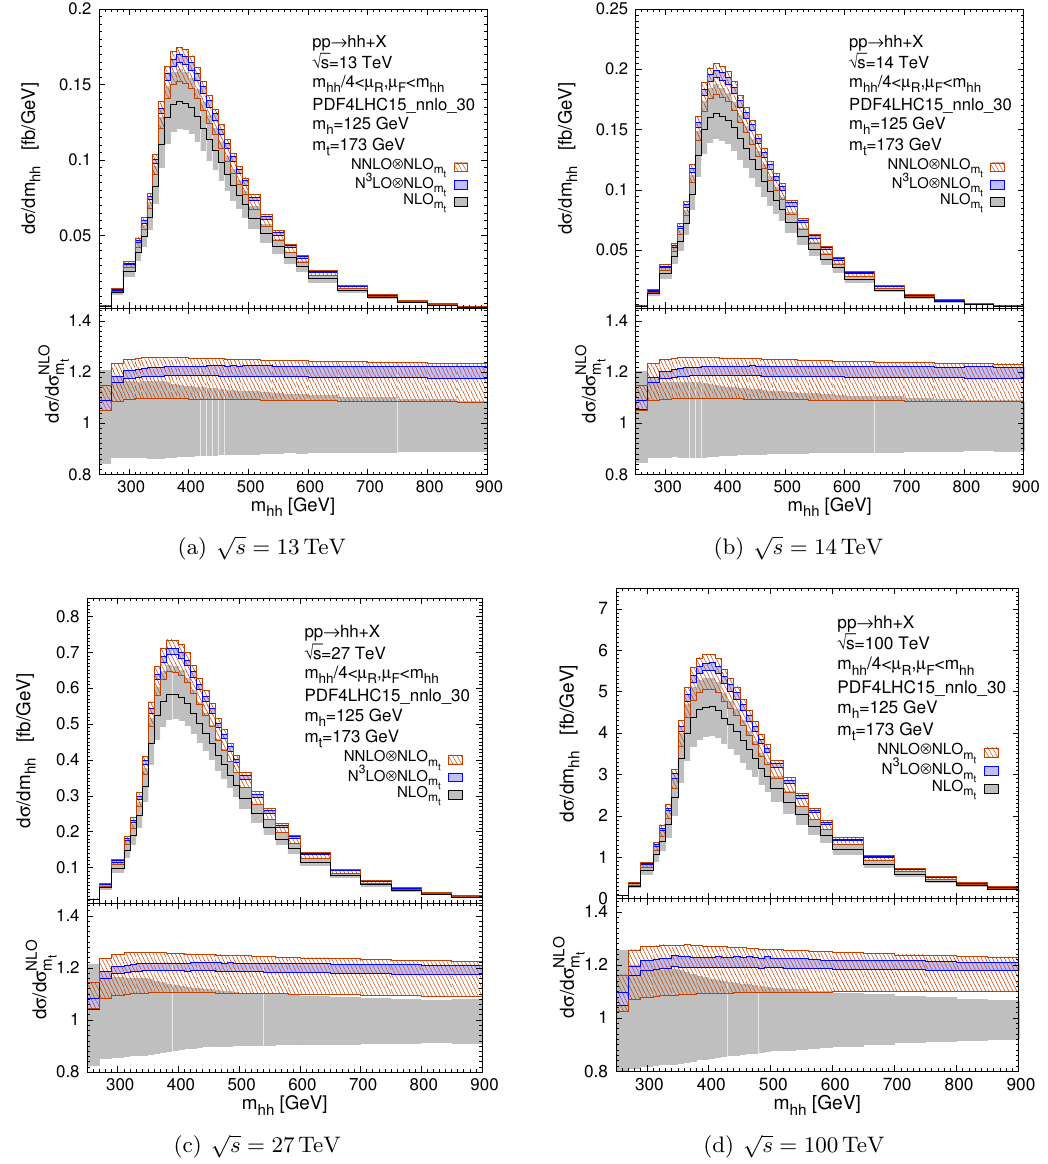
Figure 16 . Comparisons of invariant mass distributions under N 3 LO (cid:10) NLO m p approximations at s = 13 ; 14 ; 27 ; 100 TeV. The bands represent the scale uncertainties. The dark- orange, blue and black curves are the NNLO (cid:10) NLO m respectively. The bottom panel shows the ratios to the NLO m